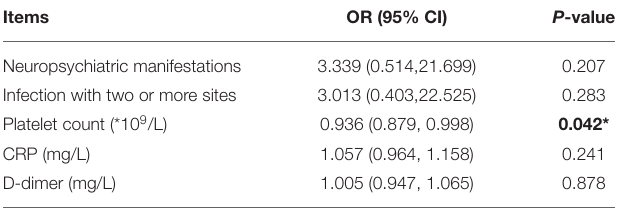
TABLE 2 | Comparisons of clinical profiles between the survival and the deceased group.